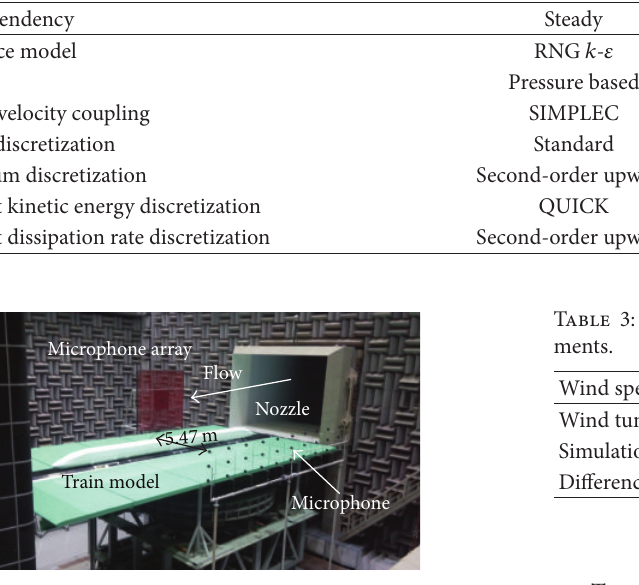
Figure 4: Photograph of the 1: 8 scale train model in the anechoic wind tunnel.